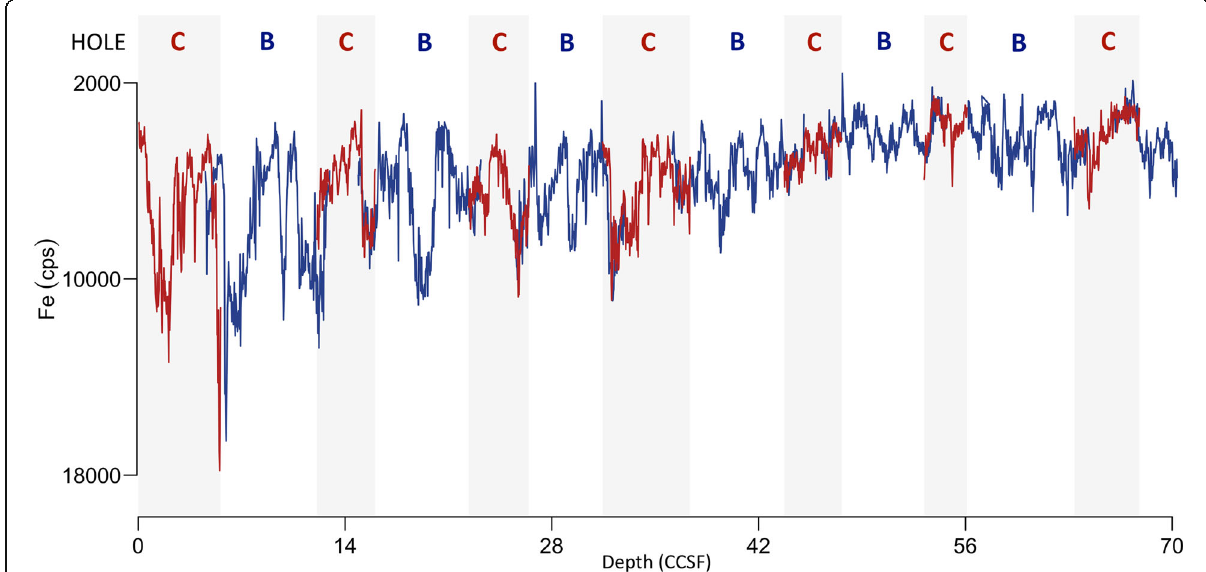
Fig. 4 The composite of Fe intensity (cps = counts per second) record comprised of segments from Holes B and C; CCSF core composite depth below sea